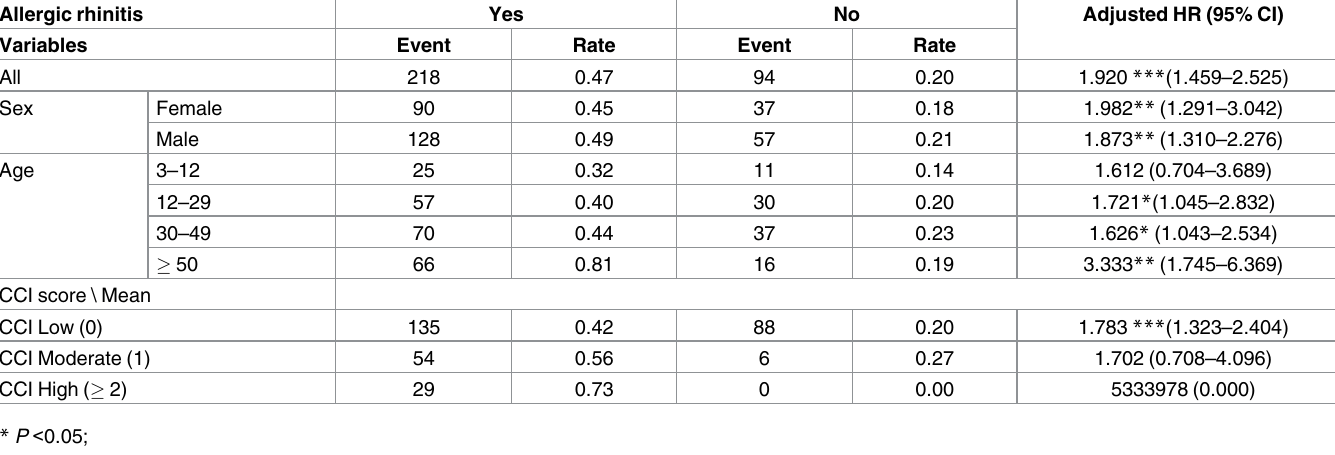
Table 2. Incidence and hazard ratios of dental trauma among patients with allergic rhinitis as compared with those without non-allergic rhinitis, based on demographic characteristics and comorbidity. Allergic